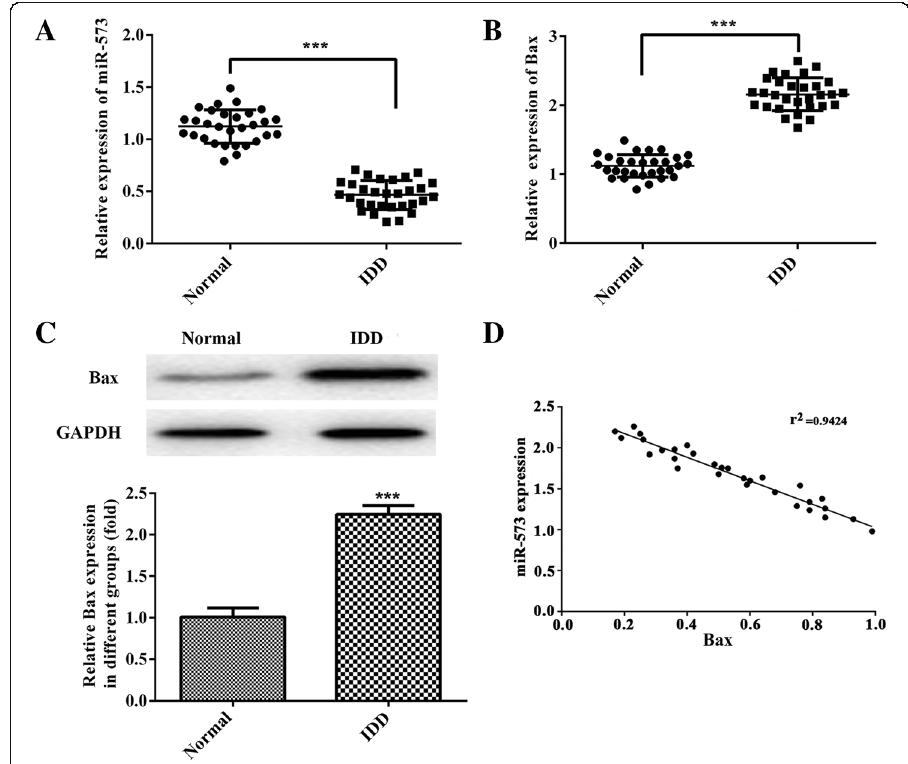
Fig. 1 Expression levels of miR-573 and Bax in IS tissues (Normal group) and IDD tissues (IDD group) and the negative correlation between them. Relative expression levels of miR-573 ( a ) and Bax ( b ) were determined by qRT-PCR in human IDD tissues and IS tissues. c Protein expression level of Bax in both human IDD tissues and IS tissues. d Correlation analysis of mRNA levels between miR-573 and Bax in IDD tissues. *** P < 0.001 versus Normal. IS, idiopathic scoliosis; IDD, intervertebral disc